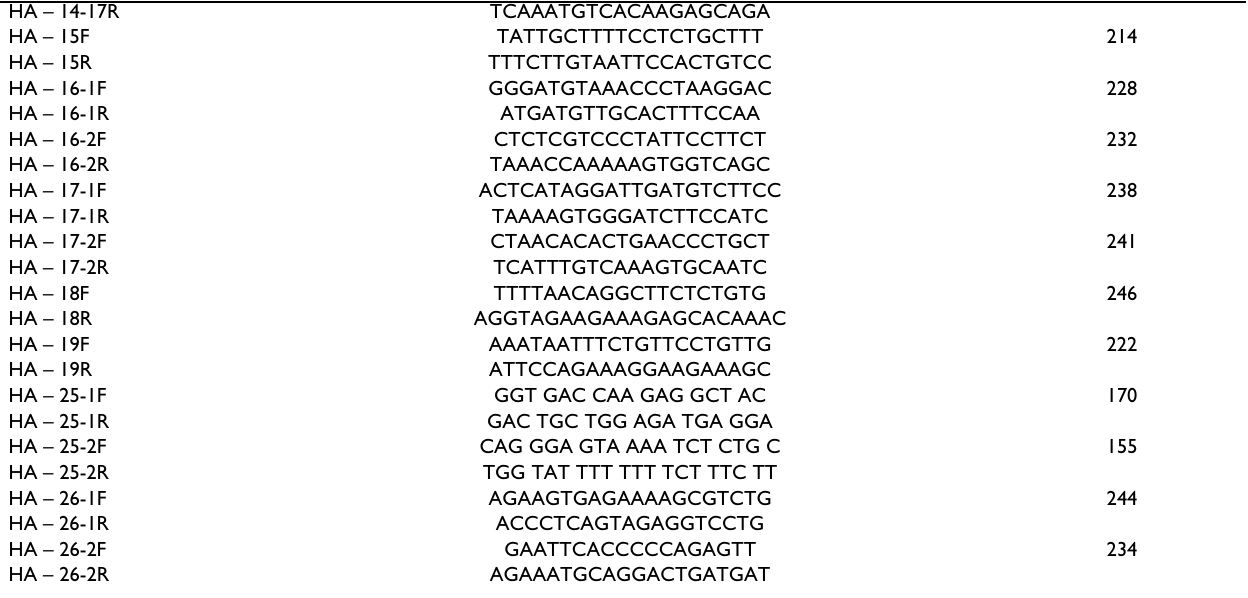
Table 2: Redesigned primer pairs for HRM